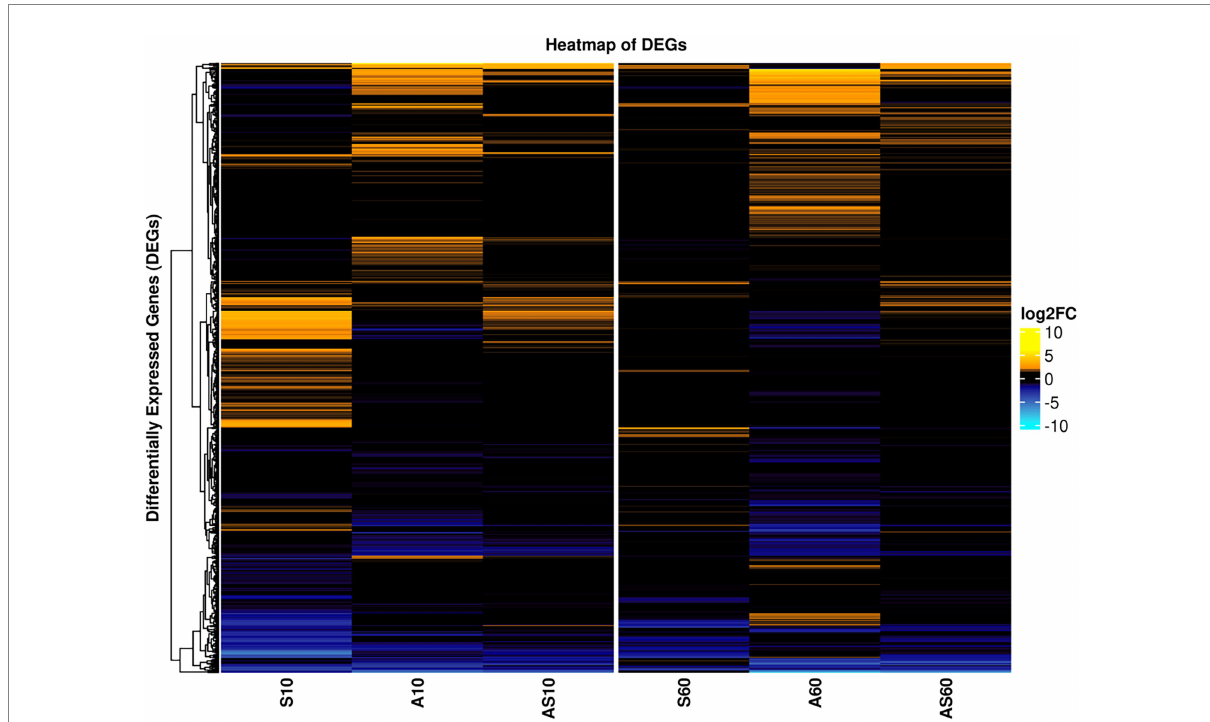
FIGURE 4 Global overview on differentially expressed genes for samples and conditions after 10 and 60 min of exposure. Pattern analysis of differentially expressed genes (DEGs) are visualized based on their log2 fold-change (log2FC) compared to the corresponding control samples, ranging from up- (yellow) to downregulated (blue). Each column corresponds to a distinct growth condition (S = serum, A = ammonia, AS = ammonia & serum) and time point (10 min and 60 min of exposure). Genes are clustered based on their respective expression across the tested conditions (left). Expression ranges from-10 log2FC to +10